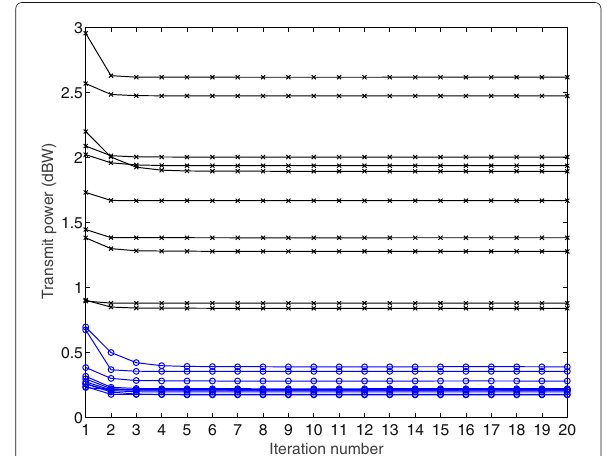
Fig. 2 The convergence performance of the first-order Taylor